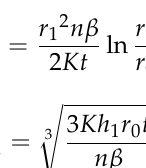
Figure 5. Law from the indoor simulation test by Du, X. [42] . Panel ( a ) displays the variation of retention rate of cement particles with migration distance at distinct water–cement ratios; ( b ) displays the variation of permeability with migration distance at distinct water–cement ratios.